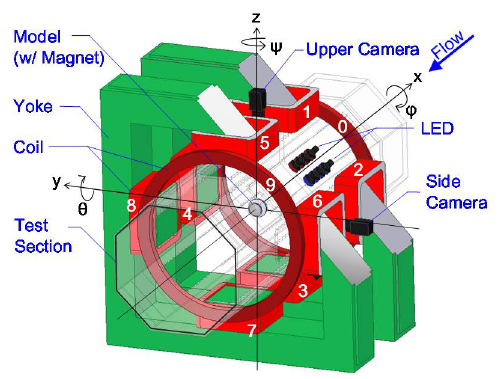
Figure 1. Schematic view of 1-m MSBS.